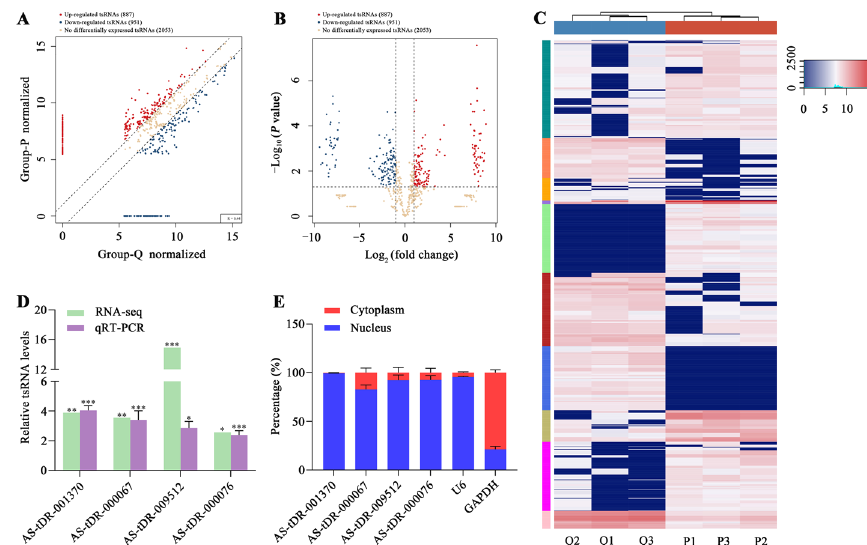
Fig. 1 Expression profile analysis and qRT‑PCR detection of tsRNAs. A Scatter plot of DEtsRNAs between proliferative and quiescent HASMCs. TPM values (log 2 scaled) of all tsRNAs; B Volcano plot of DEtsRNAs between proliferative and quiescent HASMCs; C Heatmap of DEtsRNAs between proliferative and quiescent HASMCs. Each row represents a tRNA, while each column represents a sample. P1, P2, and P3 represent three samples of proliferative HASMCs; Q1, Q2, and Q3 represent three samples of quiescent HASMCs; D Expression of four DEtsRNAs in proliferative and quiescent HASMCs was detected by qRT‑PCR and normalized to U6. Data presented as mean SD of three independent experiments, * p < 0.05, ** p < 0.01, *** p < 0.001 ± versus quiescent HASMCs. The p ‑value represents the possibility of a difference in tsRNA expression between proliferative and quiescent HASMCs; E AS‑tDR‑001370, AS‑tDR‑000067, AS‑tDR‑009512, and AS‑tDR‑000076 were abundant in the nucleus of HASMCs. U6 and GAPDH acted as positive controls in the nucleus and cytoplasm, respectively. Data shown as mean SD of three independent ±